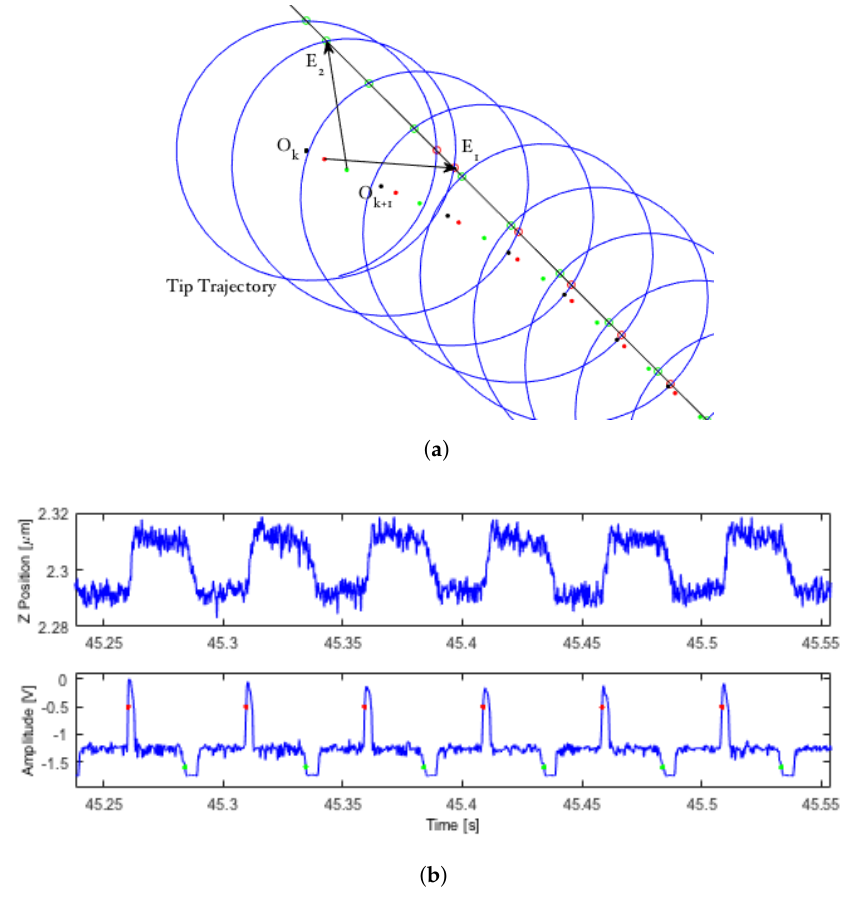
Figure 1. Demonstration of the LCS algorithm. ( a ) The moving reference frame at time step k is centered at O k , and the positions of (detected) intersections with the sample edge are indicated with open red and green circles and define the vectors E 1 and E 2 . The next center location is calculated according to Equation (1) and the reference frame smoothly moved between those points (along red and green dots) as the tip location evolves (illustration of the circle center update law); ( b ) Experimental ( top ) z and ( bottom ) amplitude signals from a typical scan. Red and green dots indicate detected sample edge locations in the data ( z position and amplitude signals for a typical LCS scan along the edge of a